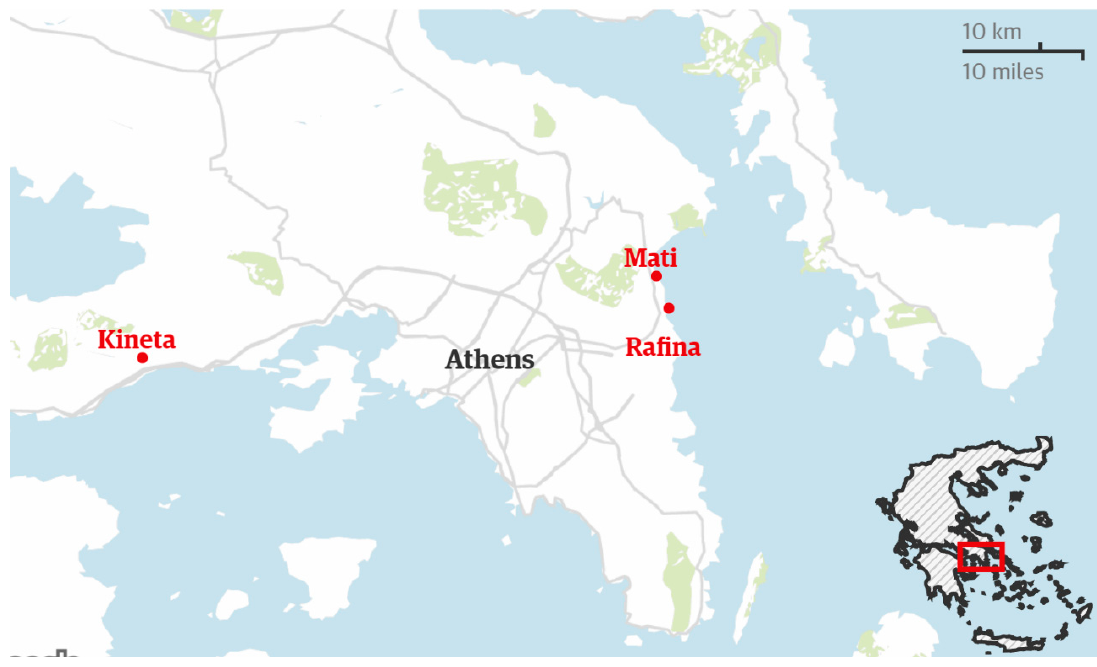
Figure 1. Study area illustrating the position of Attica in Greece (right insert), the position of downtown Athens in Attica, the location of recent, severe wildfires (July 2018) in the area (Kineta and Mati, Rafina), and the largest pastureland in green (Source: reference [76]).